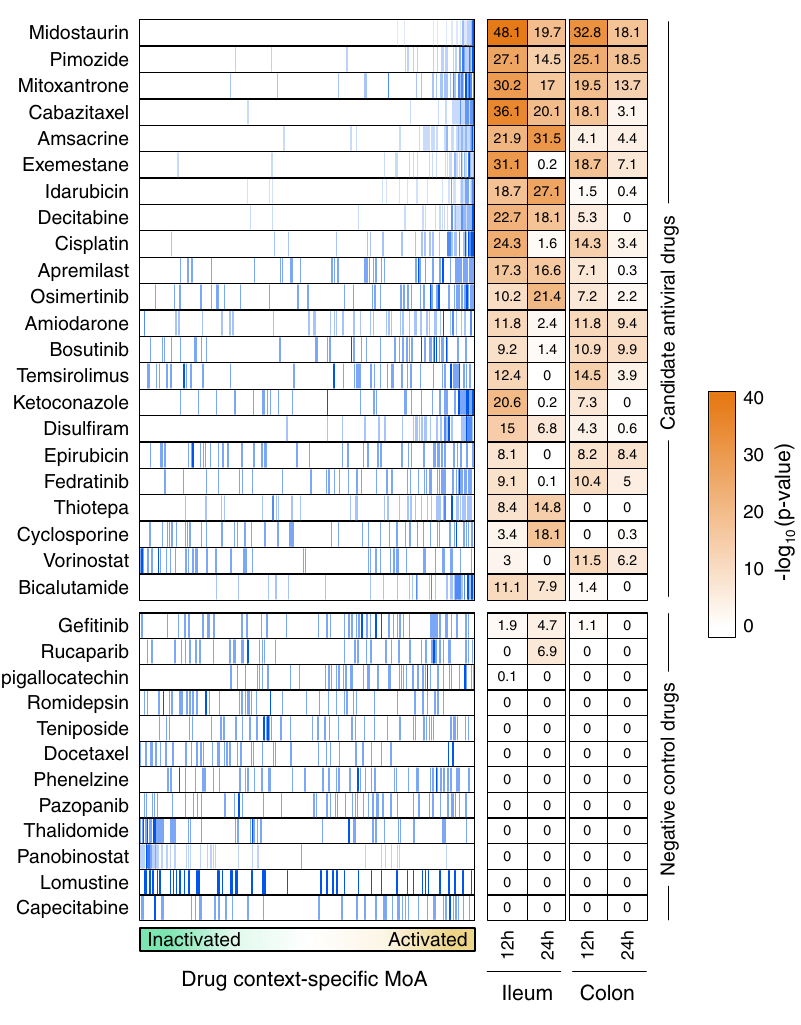
Fig. 3 ViroTreat results for the GI models. Shown are the enrichment plots for the top 50 most inactivated proteins (blue vertical lines), in response to SARS-CoV-2 infection (the negative component of the viral Checkpoint) of the ileum organoid for 12 h, on the protein activity signature induced by the drug perturbations — drug context-speci fi c MoA, represented by the green-orange color scale in the x -axis — of LoVo colon adenocarcinoma cells. The heatmap shows the Bonferroni ’ s corrected -log 10 ( p -value) estimated by ViroTreat. Shown are all the 22 candidate drugs (ViroTreat p < 10 − 5 ) and 12 drugs selected as negative controls (ViroTreat p > 0.01) in both ileum and colon-derived organoids at 12 h and 24 h